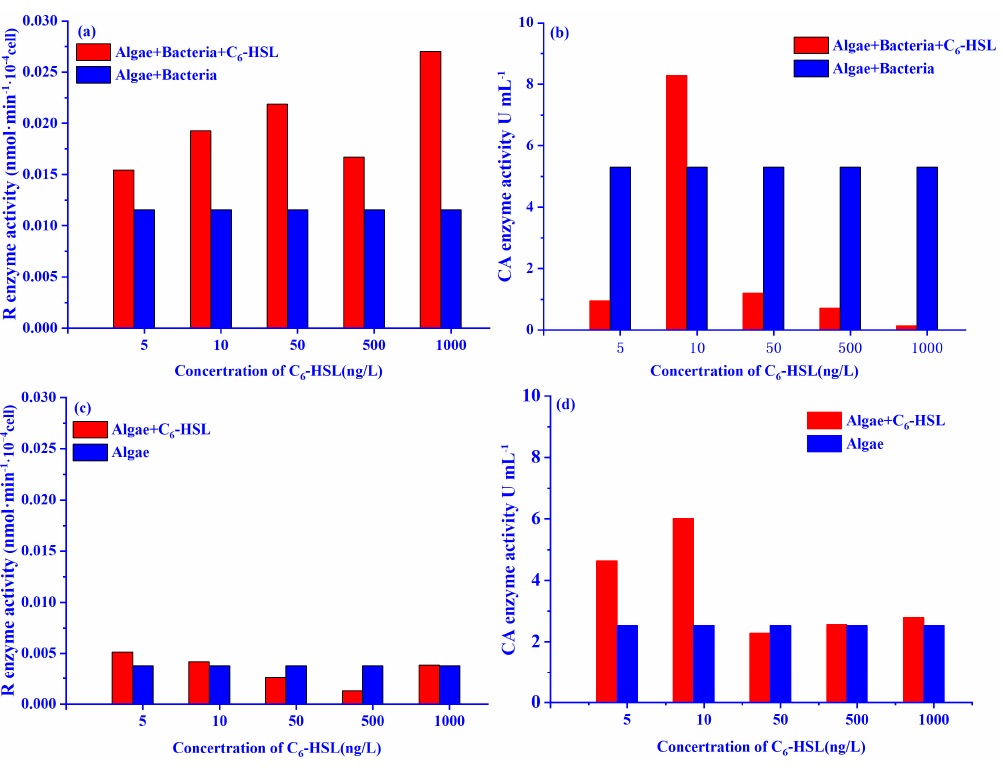
Figure 3. Effect of different concentrations C 6 -HSL on the activity of the ( a , c ) Rubisco (R) enzyme and ( b , d ) CA enzyme of algae in algal and algae–bacteria groups, respectively.